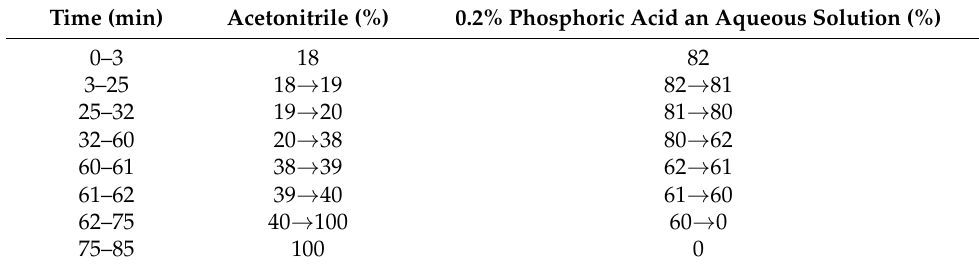
Table 4. Gradient elution